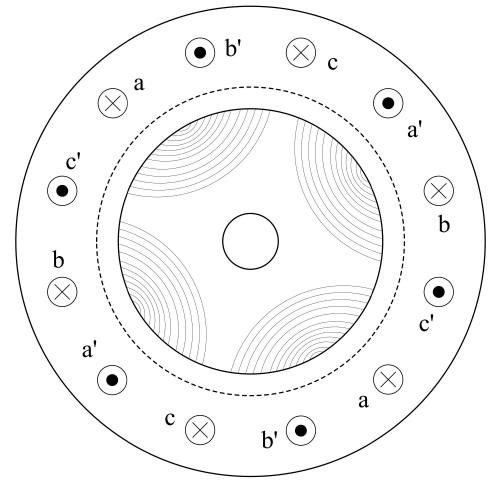
Figure 1. Synchronous-reluctance-motor (SynRM)